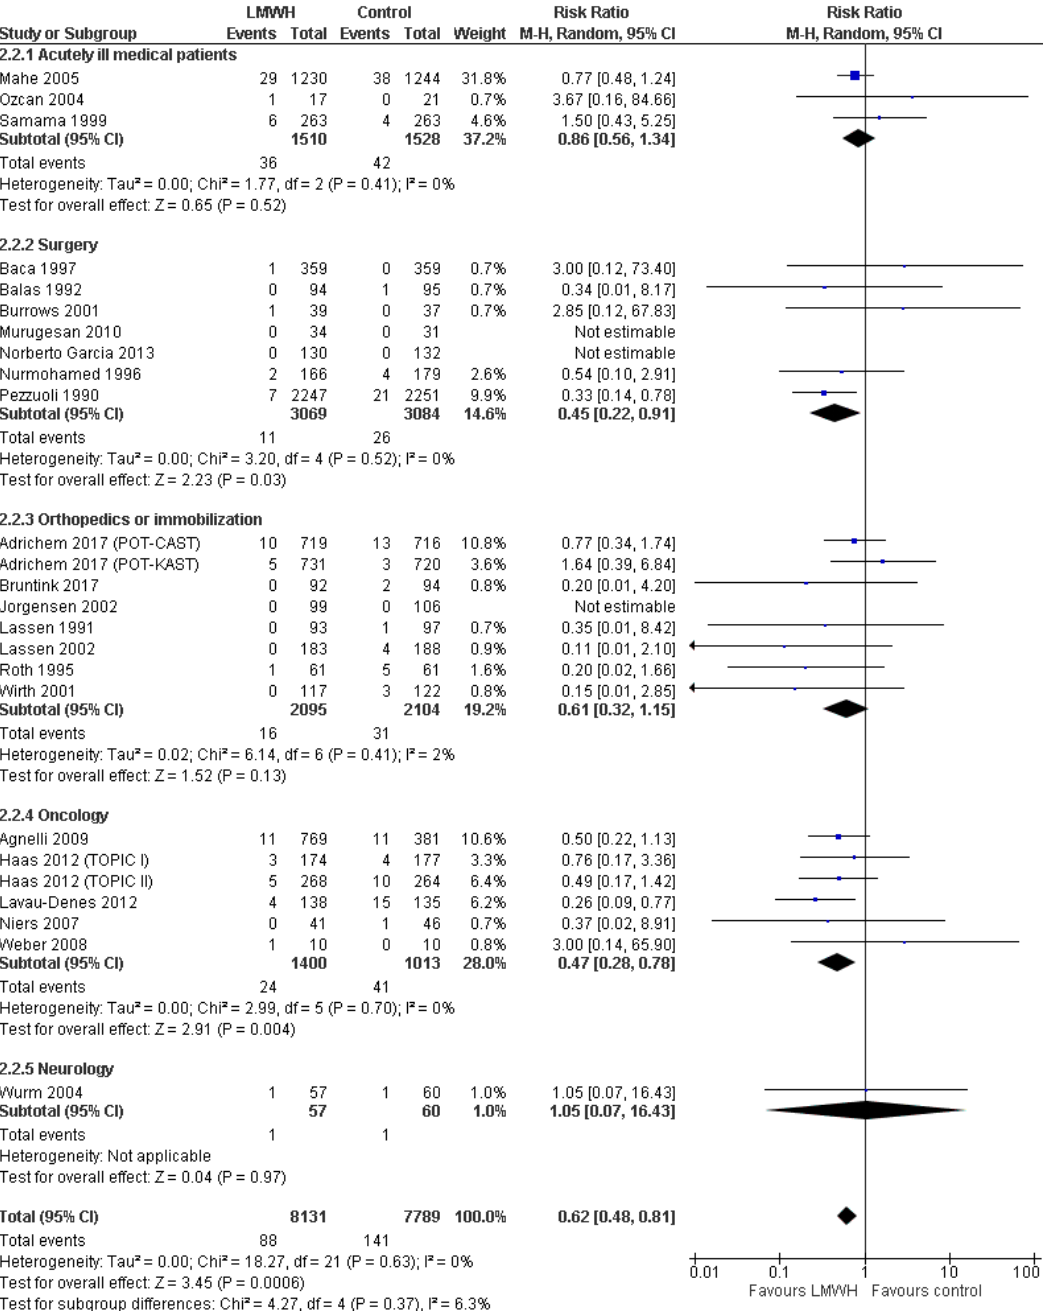
Figure 4. Forest plot of symptomatic VTE. Forest plot of symptomatic VTE at maximal follow-up of LMWH prophylaxis compared to placebo or no treatment, stratified according to patient type. The size of the squares reflects the weight of the trial in the pooled analysis. Horizontal bars represent 95% confidence intervals.